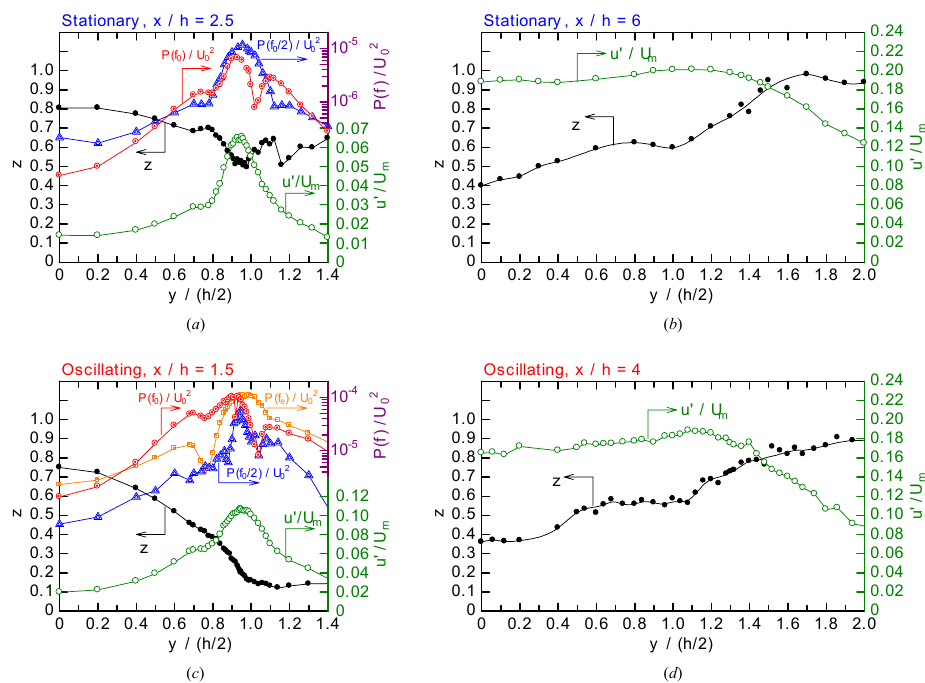
Fig. 15 Distributions of fluctuating velocity, randomness factor and power spectrum